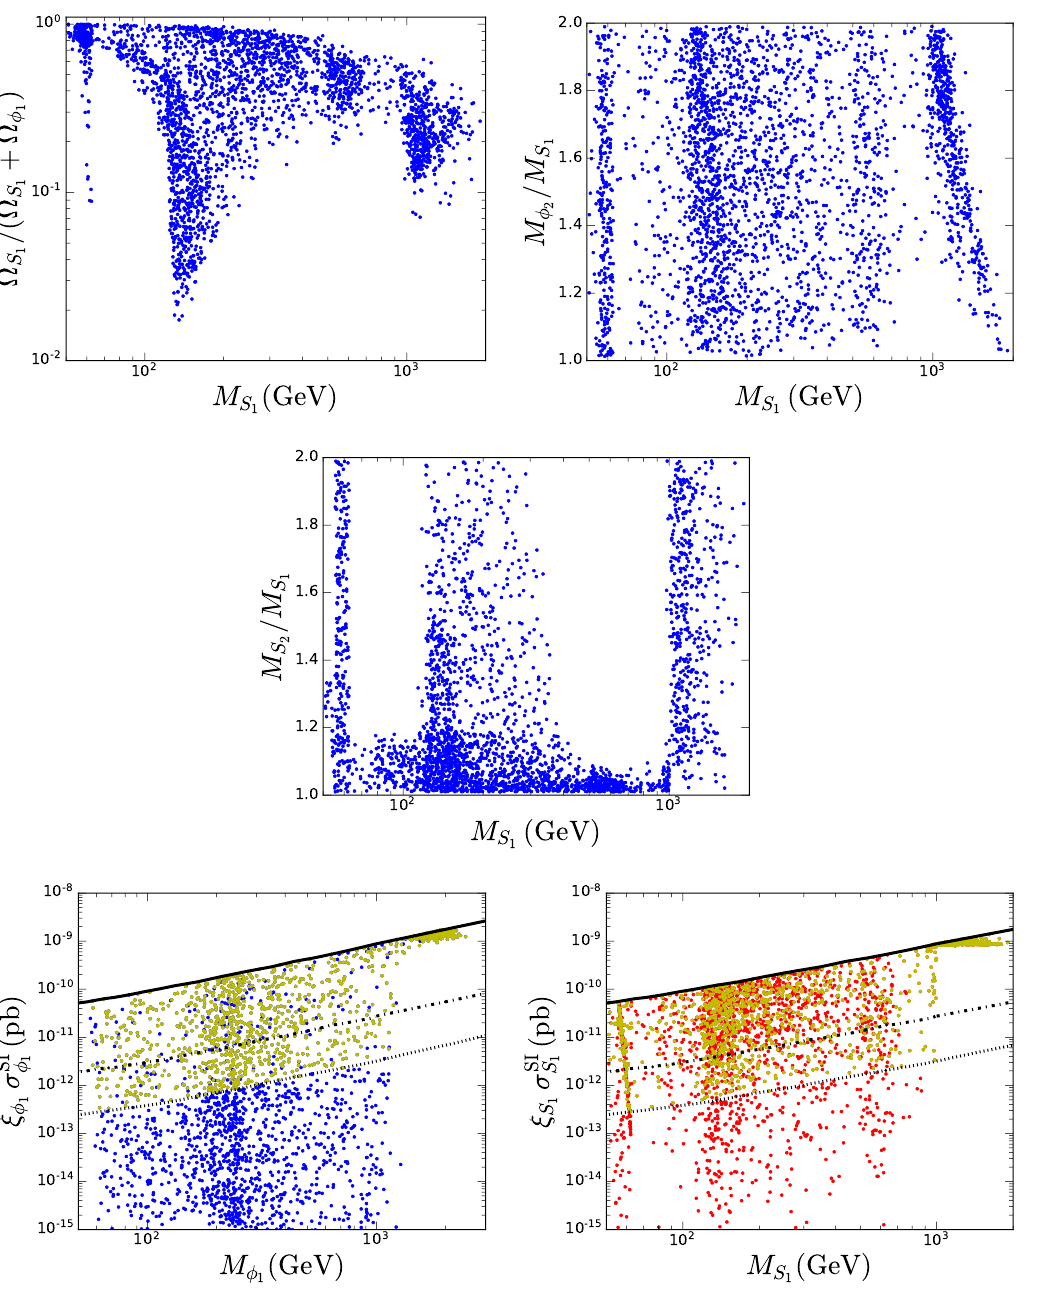
Figure 11 . A sample of viable points of the Z 6 (13) model with complex fields and M S projected along different dimensions. The top panels show scatter plots of M S (left) and versus the ratio of dark matter masses (right). The center panel show the ratio M S — see text for details. The direct detection prospects are shown in the bottom panels for φ 1 (left) and S 1